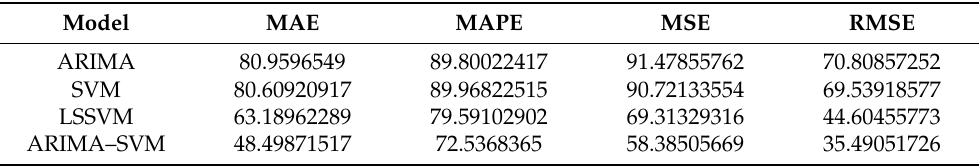
Table 6. Percentage improvement of the proposed models with other forecasting models (the COVID- 19 cases of daily new positive